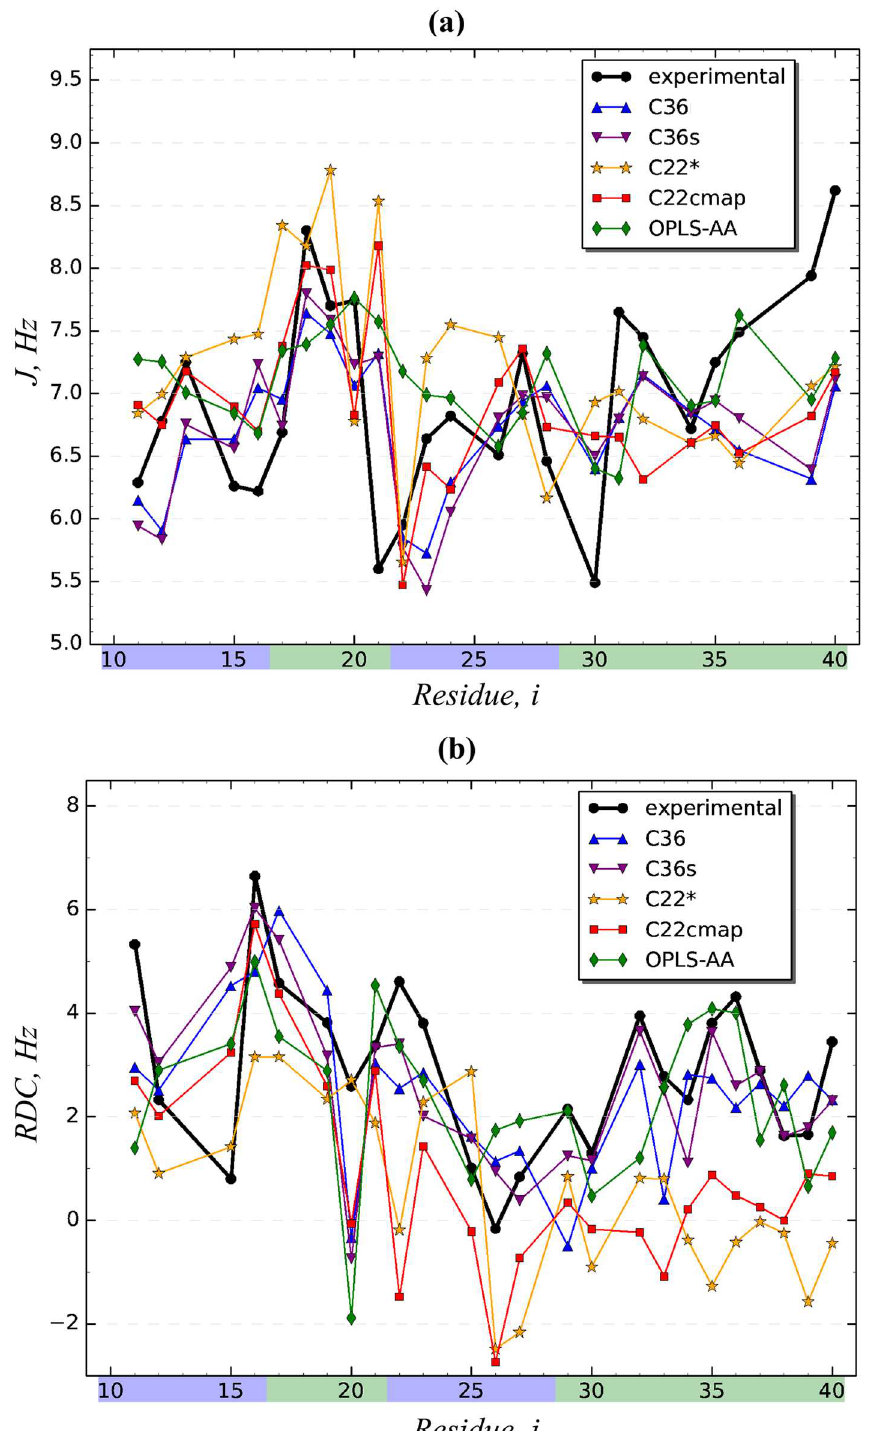
Fig 7. Comparison of in silico and experimental structural data. (a) Distributions of 3 J HNH α -coupling constants, J J exp ( i ) (black lines with circles) measuredby Roche et al [18]. This combination of Karplusequation coefficientsand experimental data providesthe best agreement between J comp ( i ) and J exp ( i ). Only